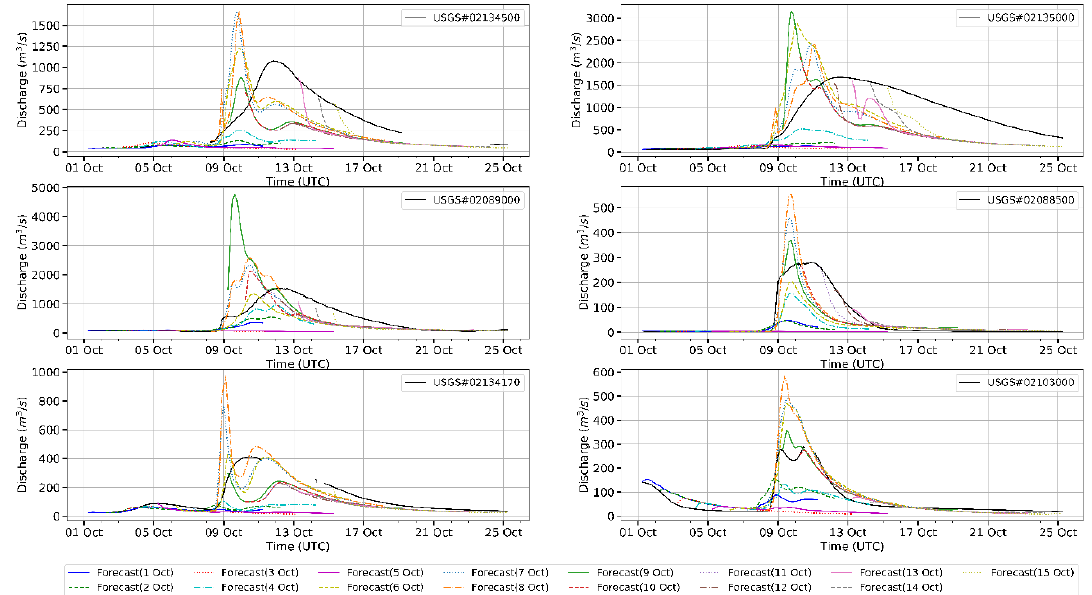
Figure 3. Comparisons between the hydrographs observed from the United States Geological Survey (USGS) stream gauges and the hydrographs developed by the National Water Model streamflow